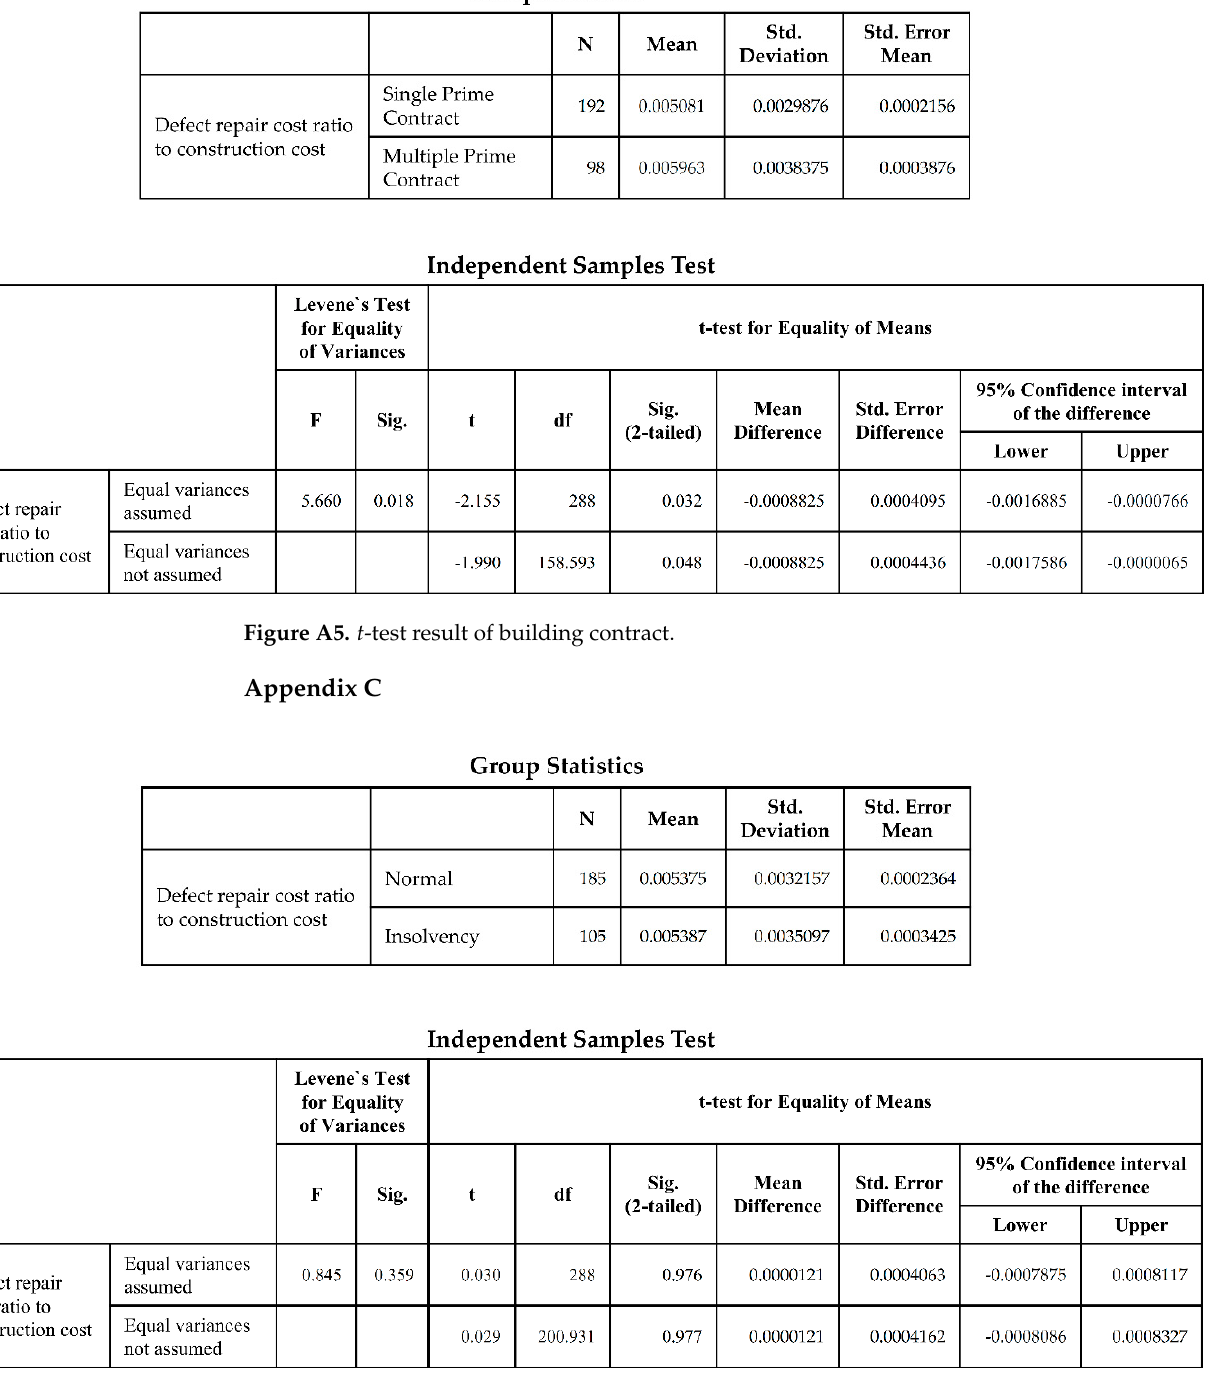
Figure A6. t -test result of developer’s Figure A6. t ‐ test result of developer’s insolvency. Figure A6. t ‐ test result of developer’s insolvency.